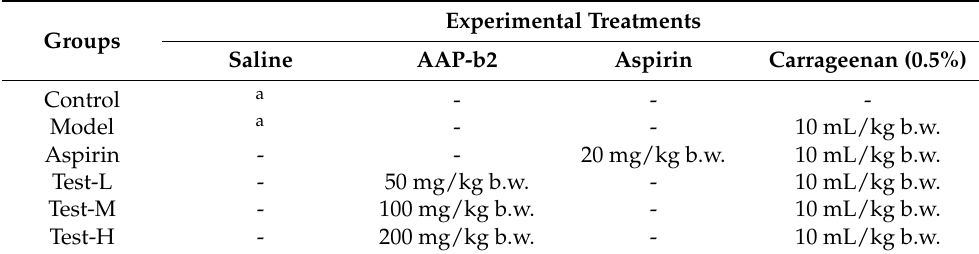
Table 2. Groups of experimental